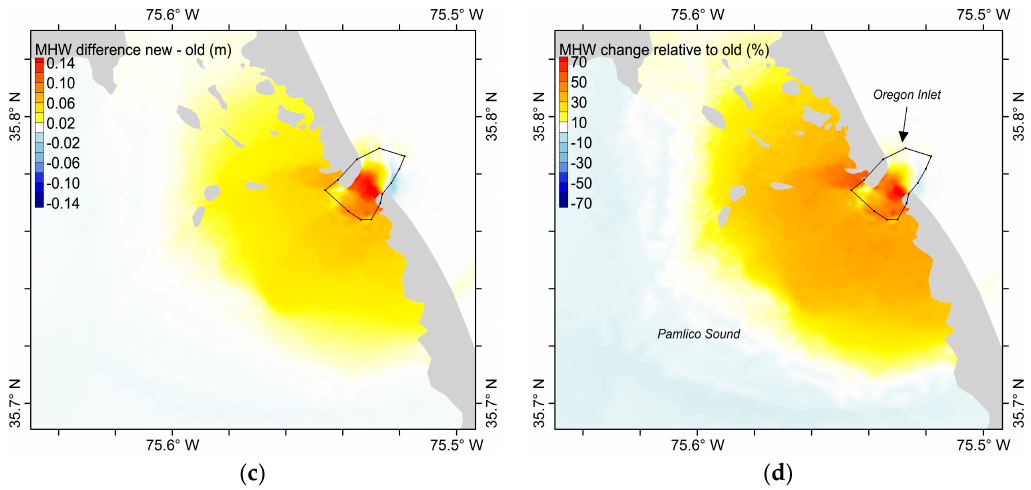
Figure 14. The MHW changes induced by the inlet morphological changes around Oregon Inlet: ( a ) MHW from the old-bathy model; ( b ) MHW from the new-bathy model; ( c ) the MHW difference between the new-bathy model and the old-bathy model; ( d ) the MHW change in percentage relative to the old-bathy model MHW. The black dotted polygons delineate the area with changed bathymetry.